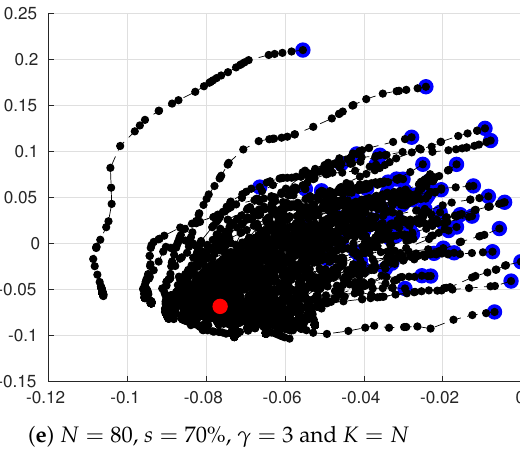
, dashed black lines together k